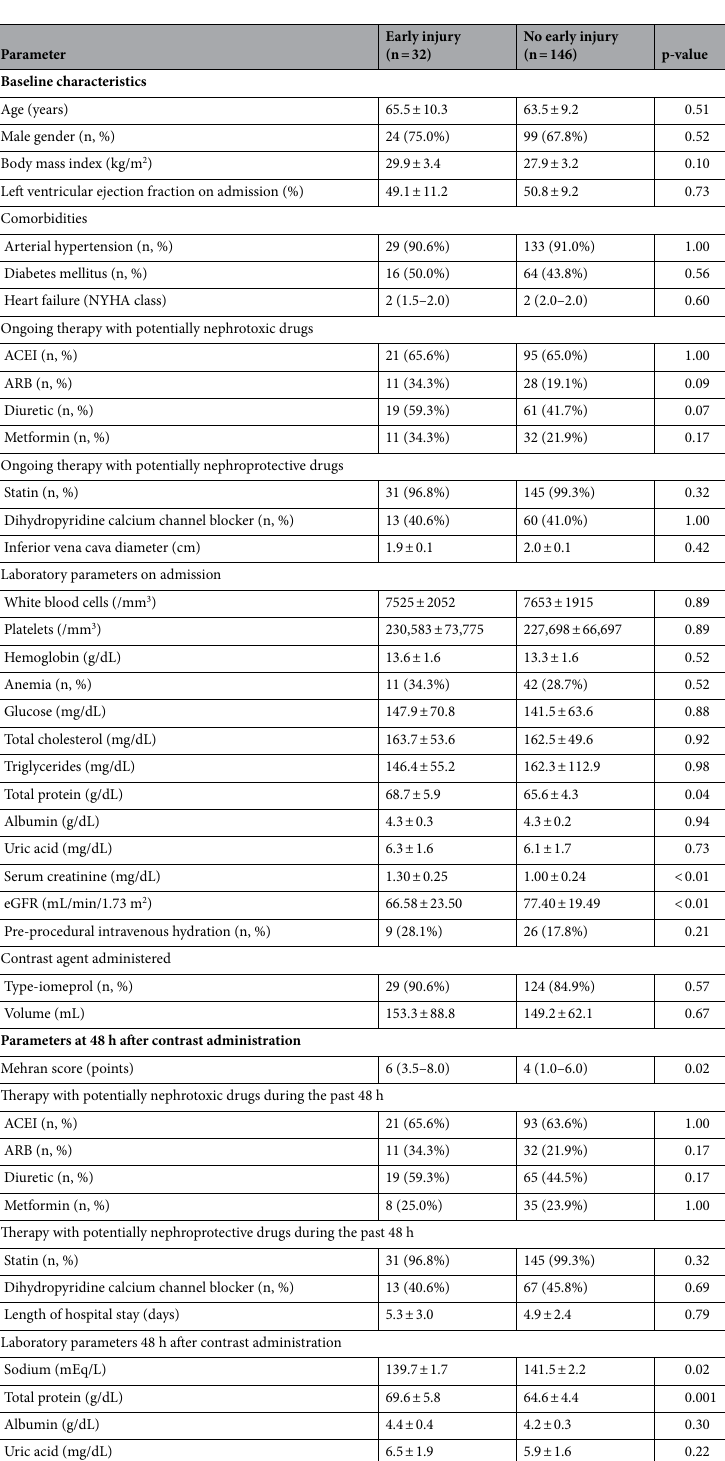
Table 4. Characteristics of patients who developed versus those who did not develop early subclinical kidney injury. Early subclinical kidney injury (early injury) was defined as an increase in NGAL by at least 25% 48 h following contrast administration vs . baseline. Anemia was considered present when hemoglobin was < 13 g/ dL and/or the hematocrit was < 39% in males, and when hemoglobin was < 12 g/dL and/or the hematocrit was < 36% in females, respectively. Quantitative data are expressed as mean values ± standard deviation or median and interquartile range, as appropriate. Categorical data are expressed as number (percentage). p-values refer to comparisons between patients with and without early subclinical kidney injury based on the unpaired t -test or the Mann–Whitney U test, as appropriate, for continuous variables, and Fisher’s exact test for categorical variables. ACEI angiotensin converting enzyme inhibitor, ARB angiotensin II receptor blocker, eGFR estimated glomerular filtration rate, NYHA New York Heart